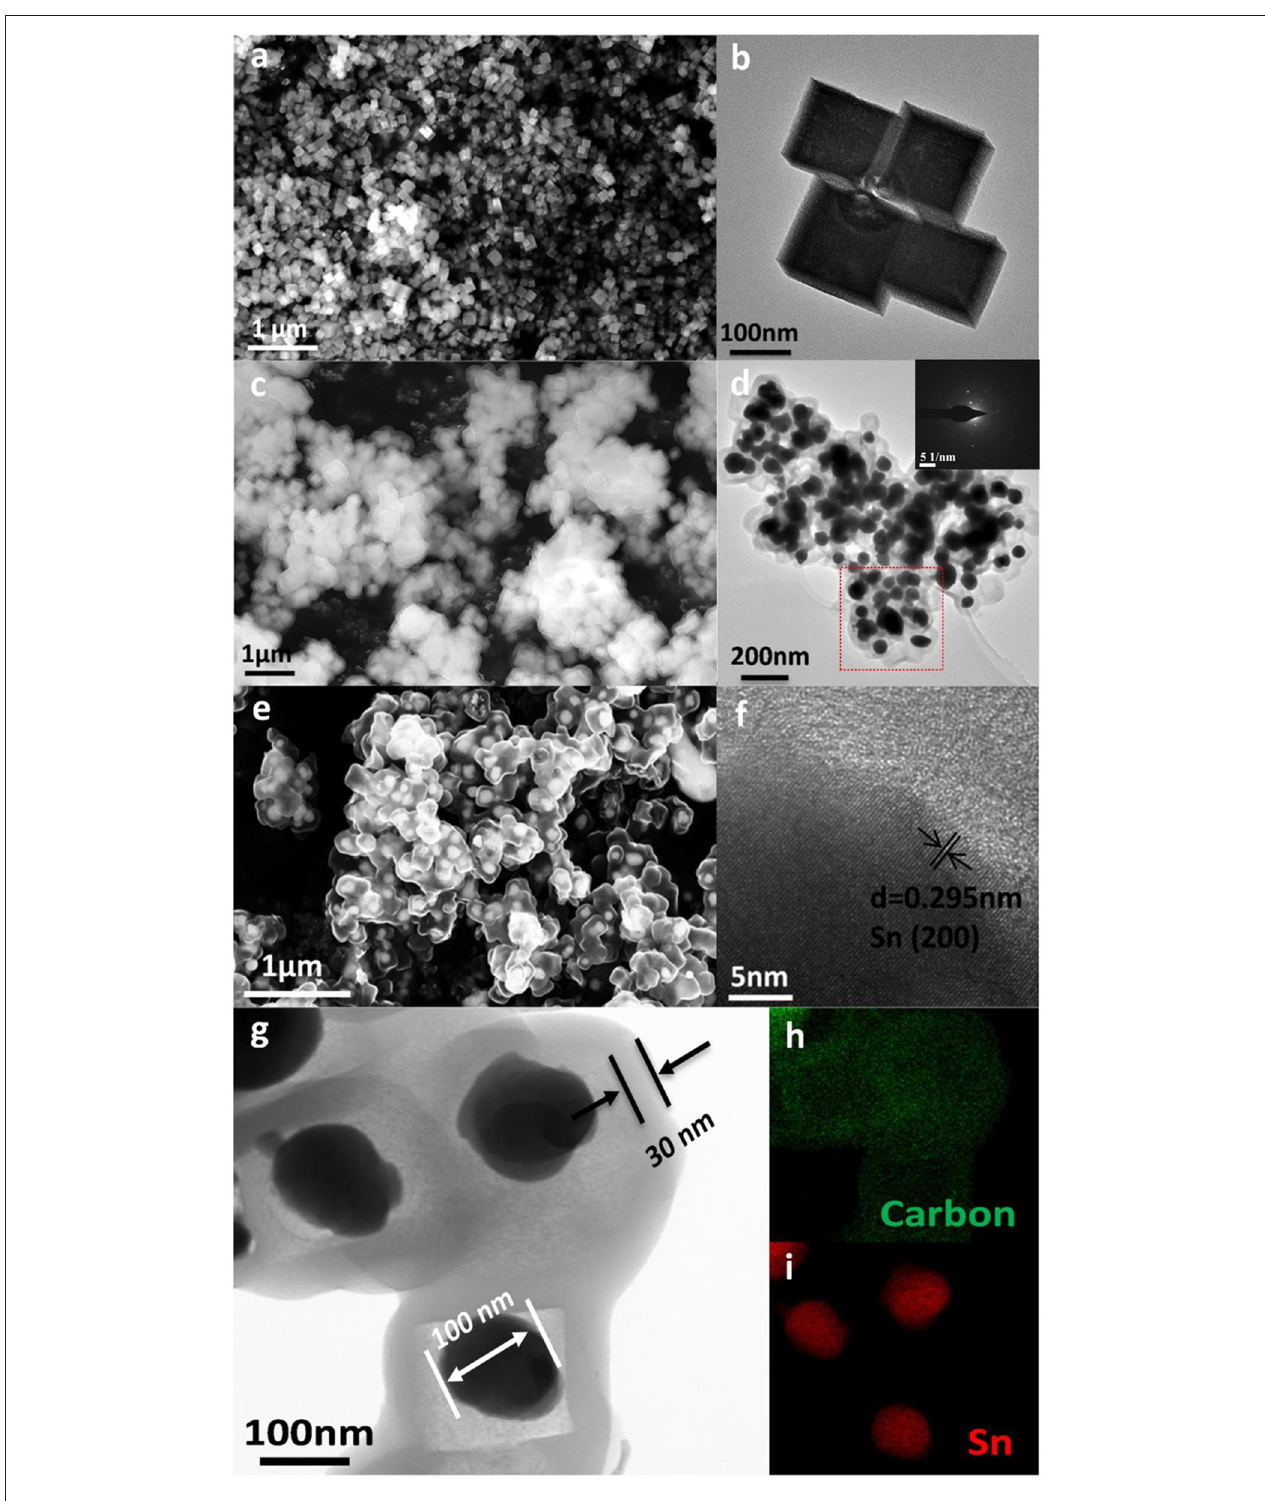
FIGURE 3 | (a) SEM, (b) TEM image of cubic ZnSnO 3 , (c) SEM of ZnSnO 3 @RF, (d) TEM, inset is its corresponding SAED patterns taken from the rectangular area, (e) SEM, and (f) high-resolution TEM image of Sn@C, (g) its corresponding STEM image, (h,i) corresponding elemental mapping of (h) Carbon and (i) Sn, respectively.